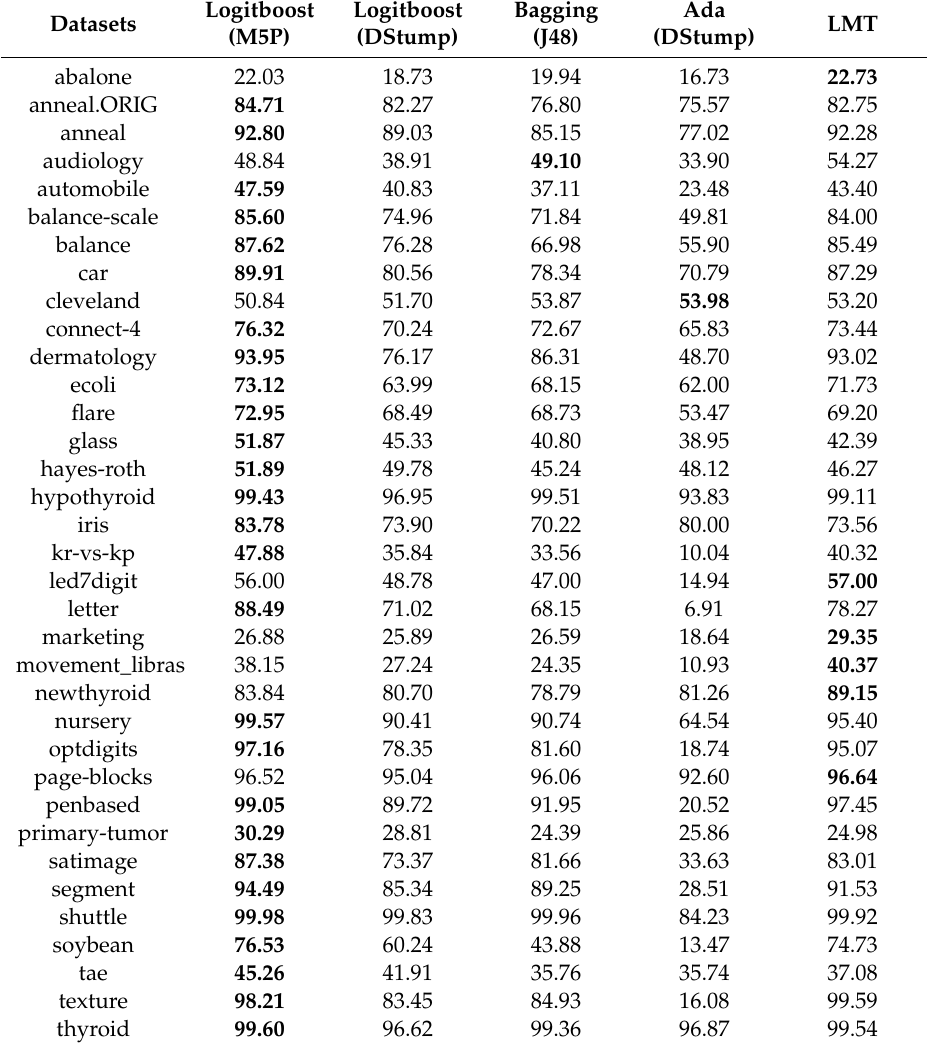
Table 6. Classification accuracy of the Logitboost(M5P) against the selected ensemble base learners for multi-class datasets under UncS(Ent) strategy with R =